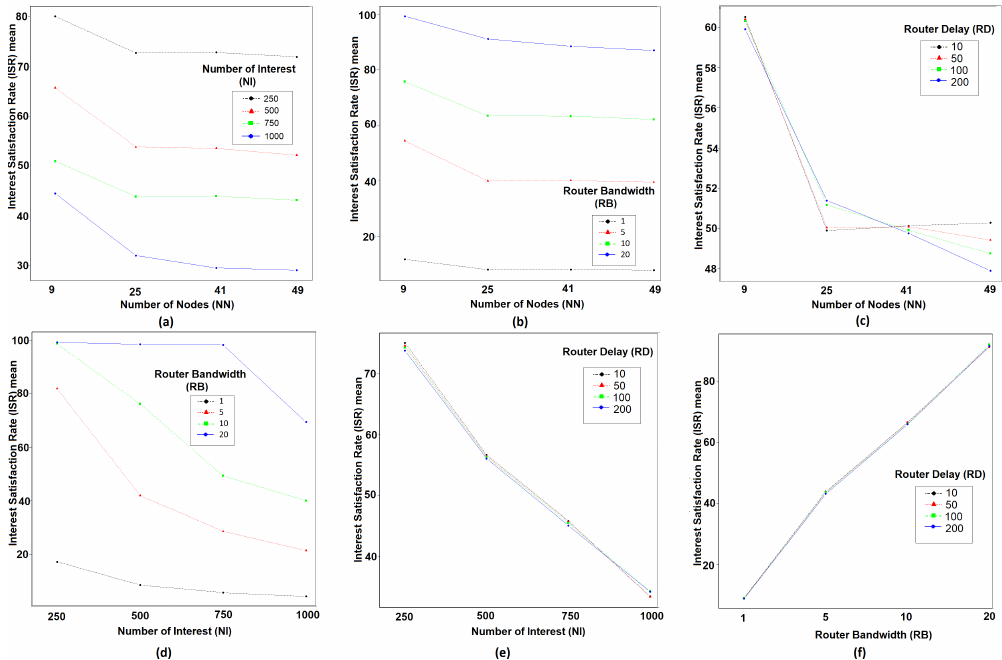
Figure 5. Interaction effect plots: ( a ) NN vs. NI, ( b ) NN vs. RB, ( c ) NN vs. RD, ( d ) NI vs. RB, ( e ) NI vs. RD, and ( f ) RB vs. RD.